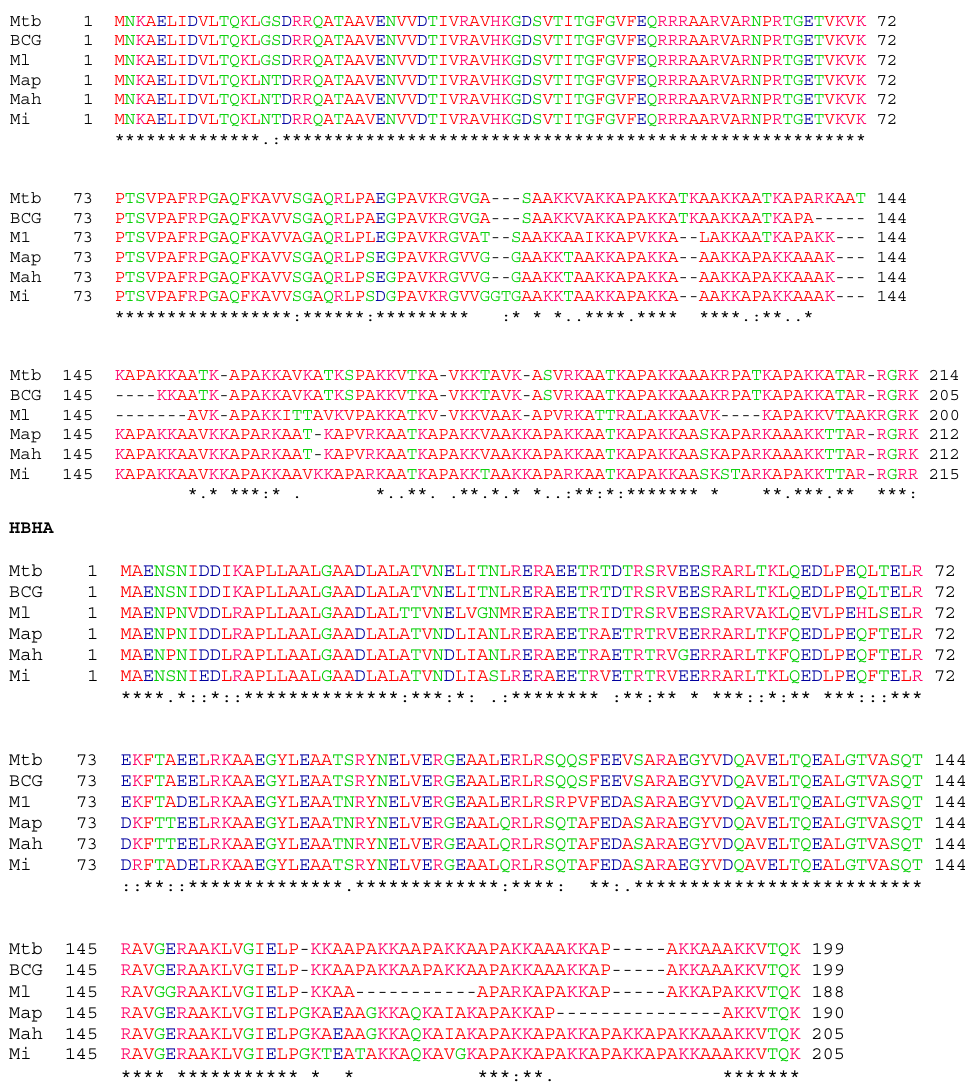
Figure 8. Sequence alignments of HBHA and LBP. Multiple sequence alignments were performed using the ClustalW program with the BLOSUM64 matrix allowing gaps ( − ). * indicate identical residues. : indicate conserved substitutions. ; indicate semi-conserved substitutions. Mtb, M. tuberculosis ; BCG, M. bovis BCG; Ml, M. leprae ; Map, M. avium subsp. paratuberculosis ; Mah, M. avium subsp. hominissuis and Mi, M. intracellulare . Color code: Pink, Polar positively charged residues HKR; Green, Polar non-charged residues GNQSTY; Blue, Polar negatively charged residues DE and Red, other residues.